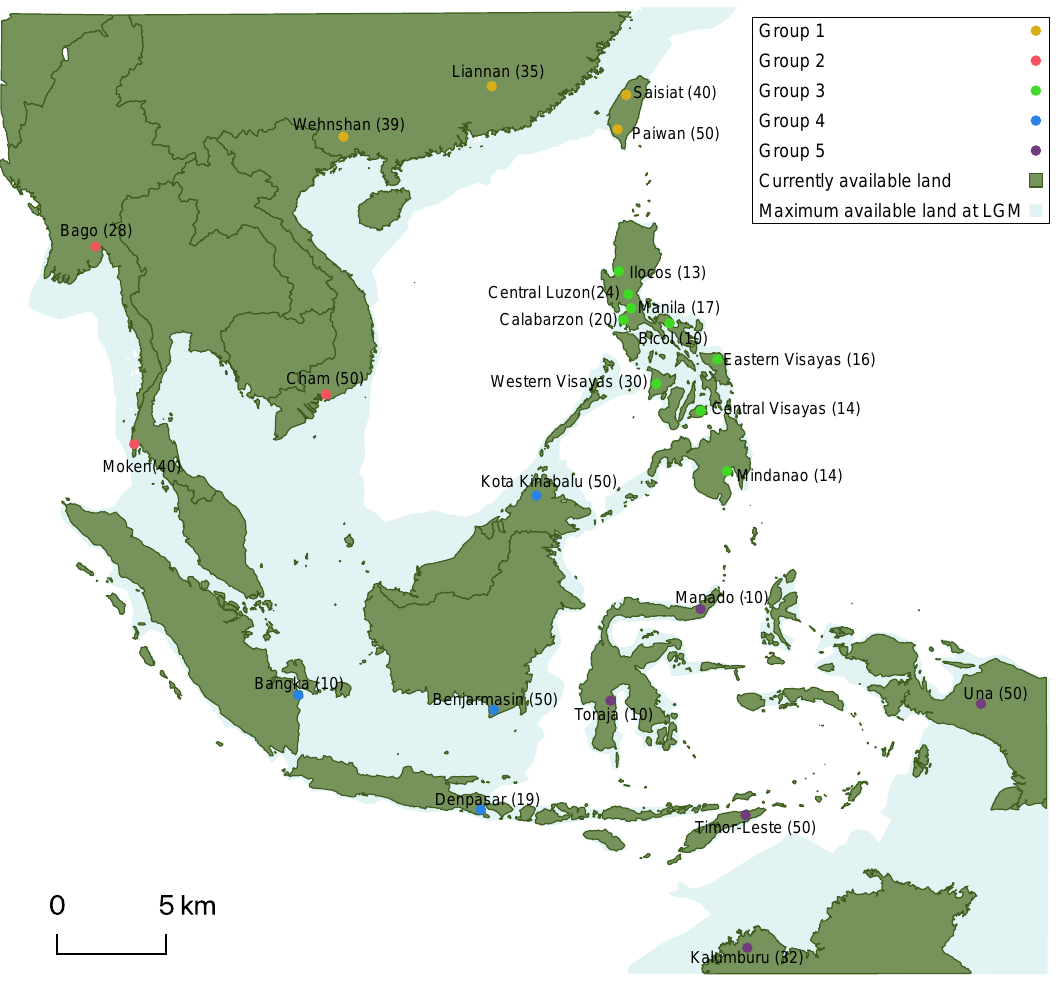
Figure 1. Studied sample locations and land distribution at the present and during the last glacial maximum (LGM) in Southeast Asia. The map shows the sampled populations (for every population the number of individuals is included in parenthesis) and their classification into five geographic groups (shown with colors; for further details, see Table S1). The land available at present is shown in dark green while the land available when the sea level was 120 m below present level (occurring at the LGM) is shown in clear blue.